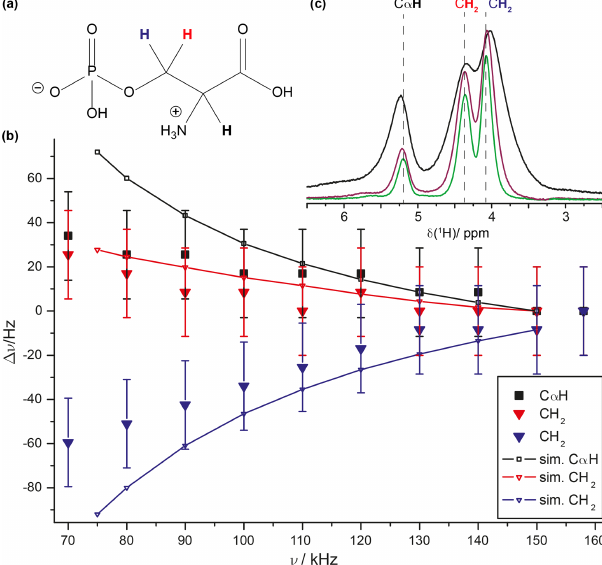
Figure 8. MAS dependence of 1 H line positions in ortho-phospho- L-serine (for the chemical structure, see panel a ). (b) The filled symbols indicate experimental data with a constant error of 20Hz. The two CH 2 protons are shown in red (high ppm peak) and blue (low ppm peak); the C α H proton is shown in black. The simula- tions were based on a three-spin system with r 12 = 1.60Å, r 23 = r 13 = 2.35Å, and θ (1 , 2 , 3) = θ (2 , 1 , 3) = 70 ◦ . Three 1 H spectra recorded with MAS frequencies of 70kHz (black), 120kHz (pur- ple), and 158kHz (green) are shown in panel (c) . The dashed lines indicate the isotropic 1 H chemical shift at 158kHz MAS. The ex- Figure 7. (a) Calculated MAS spectra for a four-spin system at periments were performed at a static magnetic field of a spinning frequency of 50kHz using different approximations of the effective Hamiltonian. All spectra were processed with an exponential line broadening of 1Hz. The spin-system param- eters are r 1 = (0 , 0 , 0)Å, r 2 = (0 , 0 , 1 . 75)Å, r 3 = (3 . 0 , 0 , 0)Å, r 4 = (3 . 5 , 0 . 0 , 2 . 0)Å, δ 12 / (2 π ) = − 44826Hz, δ 13 / (2 π ) = − 8898Hz, δ = − 3667Hz, δ = − 5734Hz, 14 / (2 π ) 23 / (2 π ) δ 24 / (2 π ) = − 5561Hz, δ 34 / (2 π ) = − 27420Hz. The Euler an- gles can be calculated from the coordinates given above. The spectral window was set to 2000Hz with 20000 data points leading to a digital resolution of 0.1Hz. Ten thousand powder points were sampled according to the ZCW scheme (Cheng et al., 1973). Panels (b) – (e) show the four three-spin sub-spectra that comprise the complete four-spin spectrum shown in panel (a) .